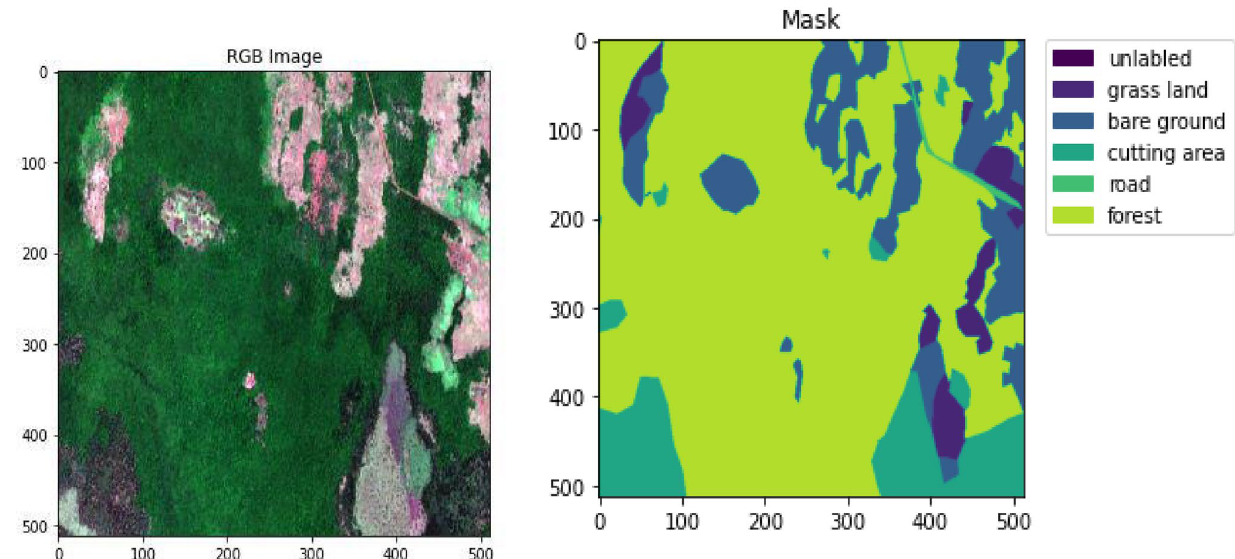
Table 2 Convolutional neural network ( CNN) parameters for the feature extraction network used in this study